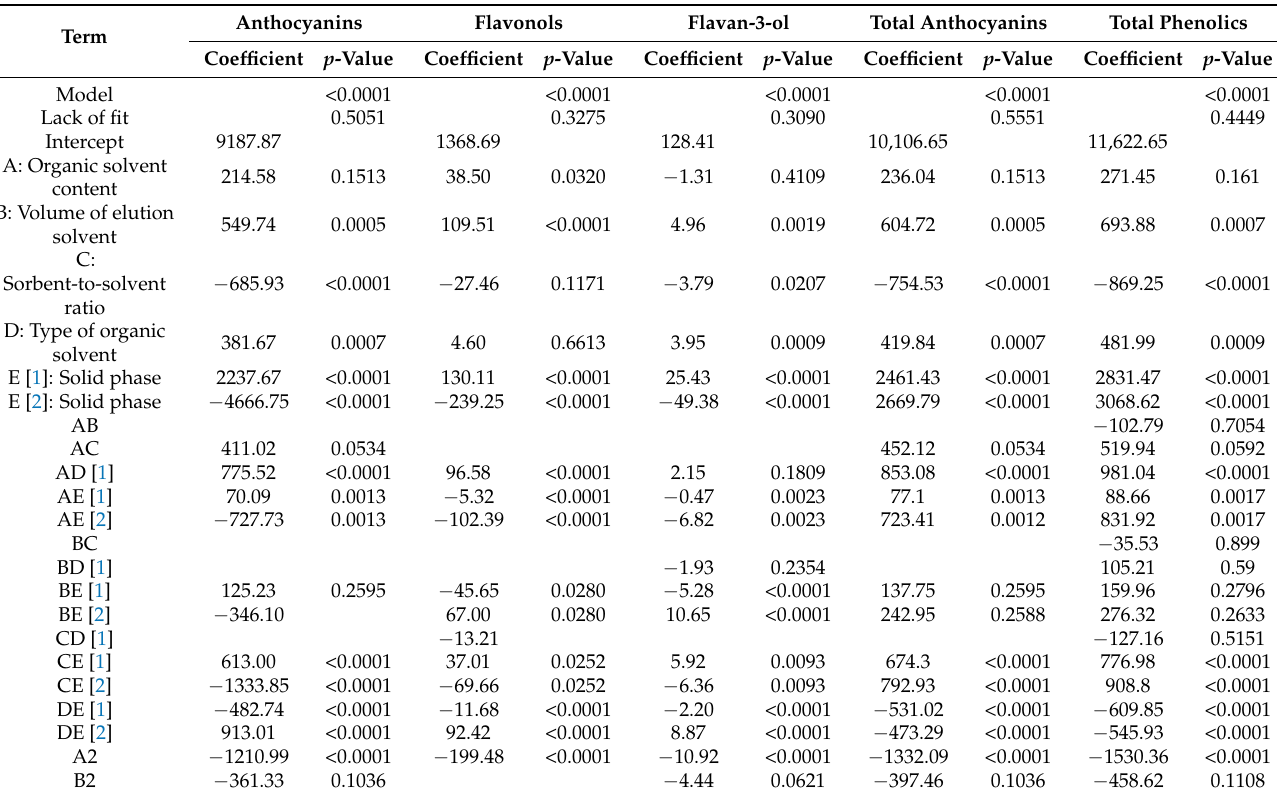
Table 7. Coefficients of the second-order polynomial equation and regression coefficients of the response and ANOVA parameters for the obtained